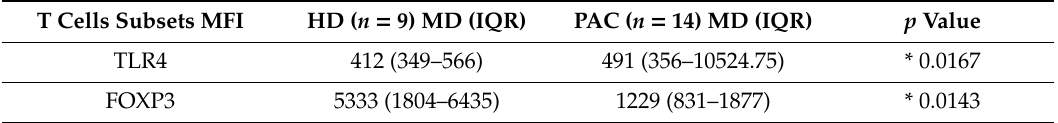
Table 3. TLR4 expression in CD4 + T cells and FOXP3 expression in CD4 + CD25 + T